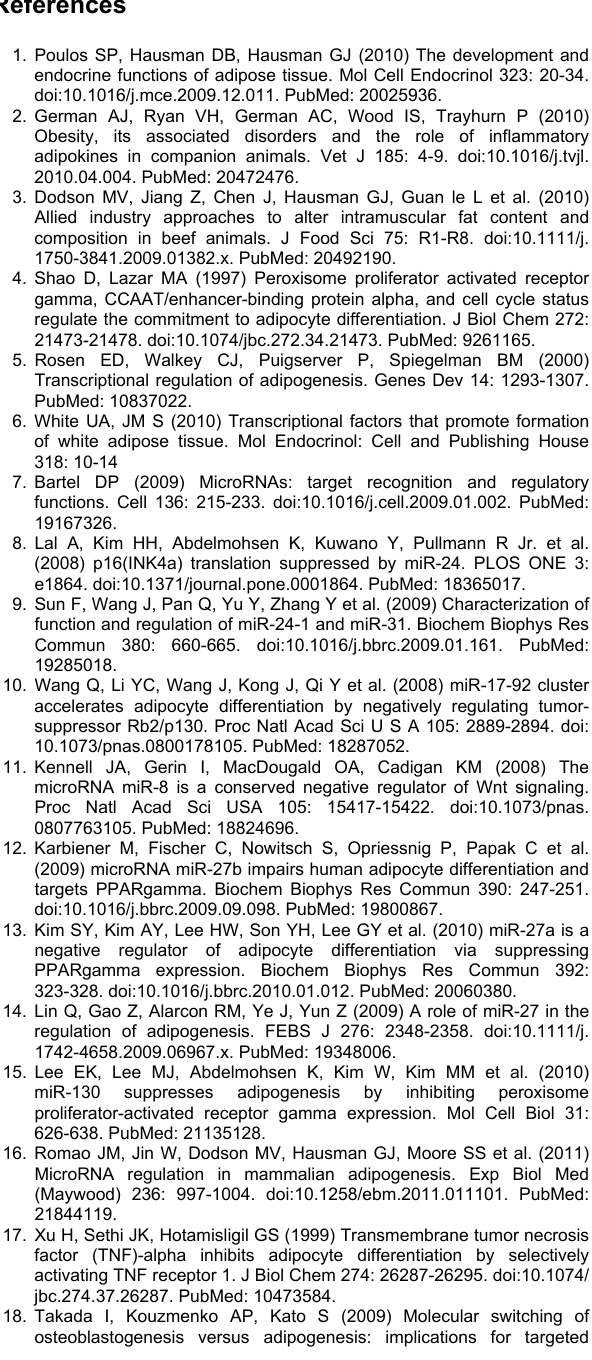
Table S1. The primers of fat metabolism related genes.